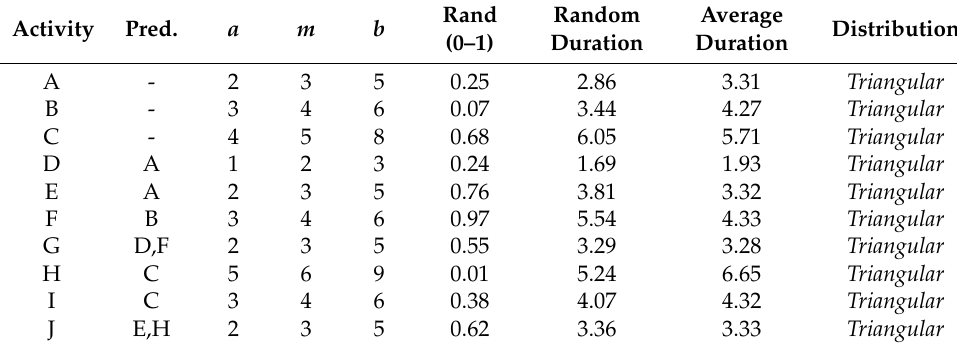
Table 3. Results of SRA for project